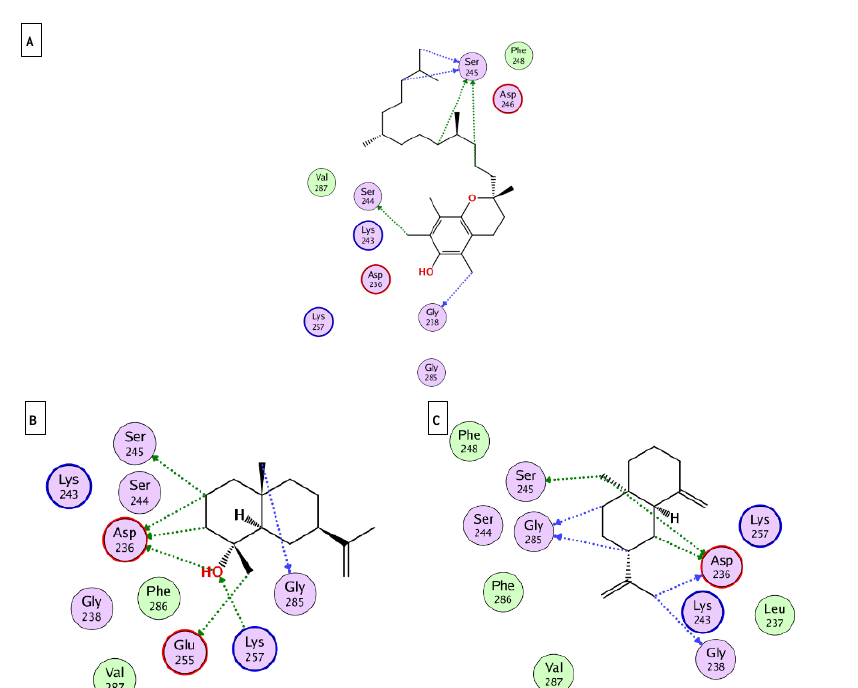
Figure 7. 2D binding modes of α -tocopherol ( A ); selin-11-en-4- α -ol ( B ); β -selinene ( C ) to the active binding sites of α -amylase.